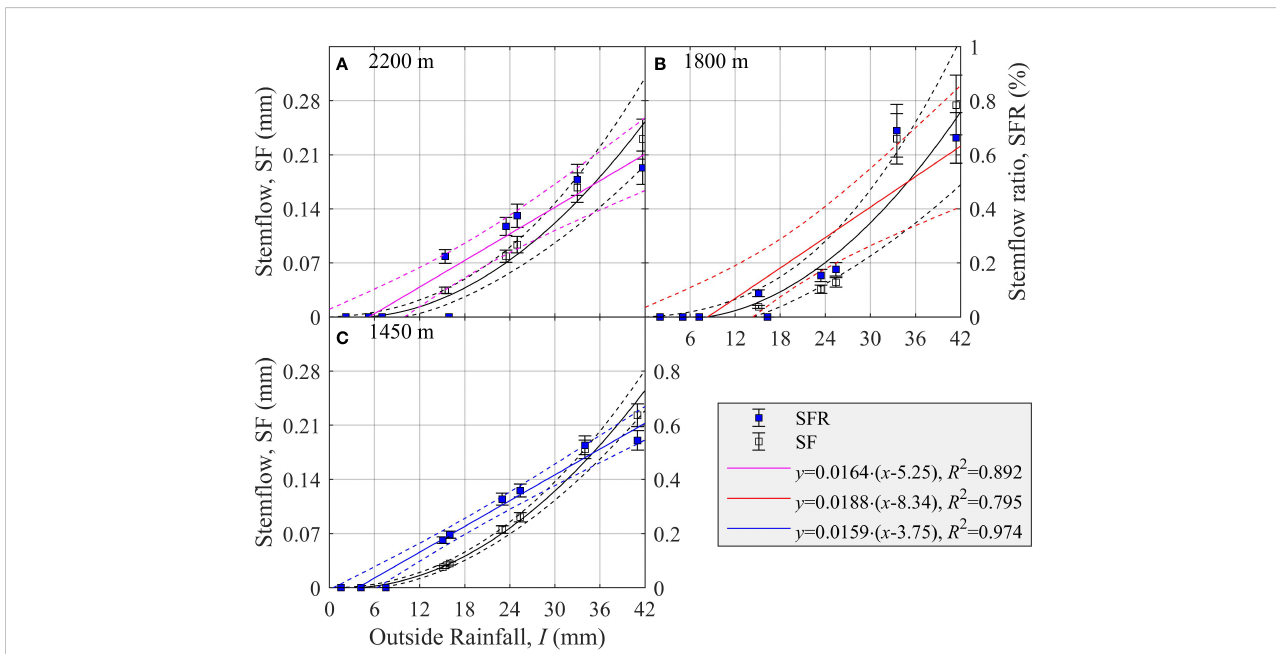
FIGURE 2 Changes in stem fl ow (SF, mm) and stem fl ow ratio (SFR, %) of Picea schrenkiana as a function of outside rainfall ( I , mm) at three elevation sites on the northern slope of Mount Bogda, Tianshan Range, Xinjiang, China. Error bars indicate the standard error of the mean ( N = 9). Dashed lines are the upper and lower 95% predicted